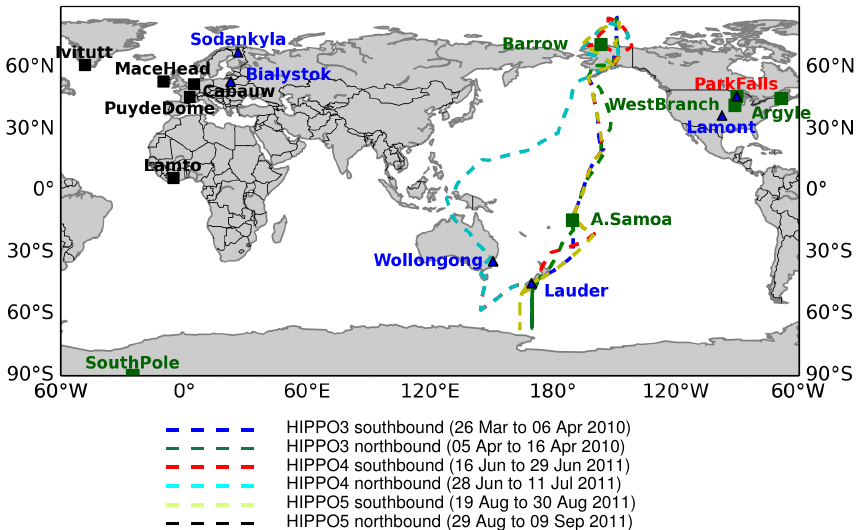
Figure 1. Maps showing the location of stations with continuous surface measurements from the NOAA/ESRL network (green squares), the ICOS network (black squares), the total column FTIR stations from the TCCON network (blue triangles) and the HIPPO flight tracks used in the evaluation of the CO 2 hindcast (dashed lines, see flight period in the legend). Note that Park Falls (in red) has both total column TCCON observations as well as tall tower observations from the ESRL/NOAA